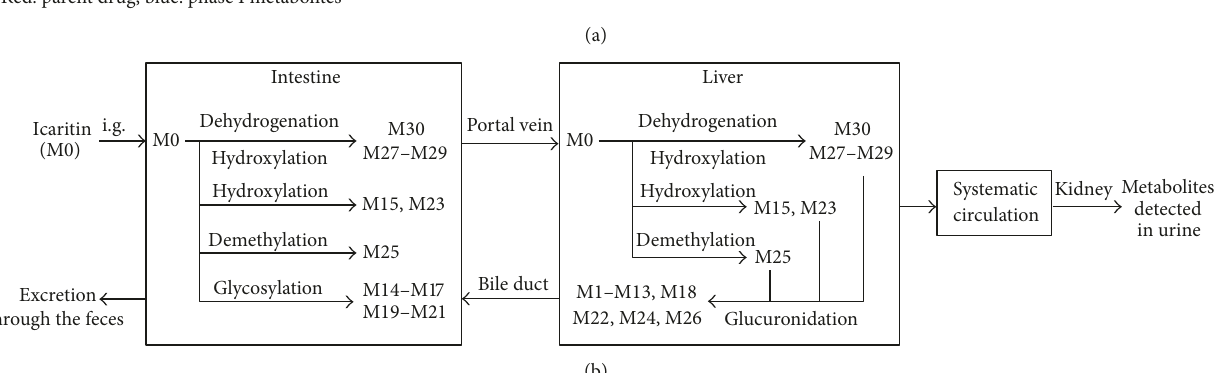
Figure 4: The proposed metabolic pathway (a) and metabolic sites (b) of icaritin in